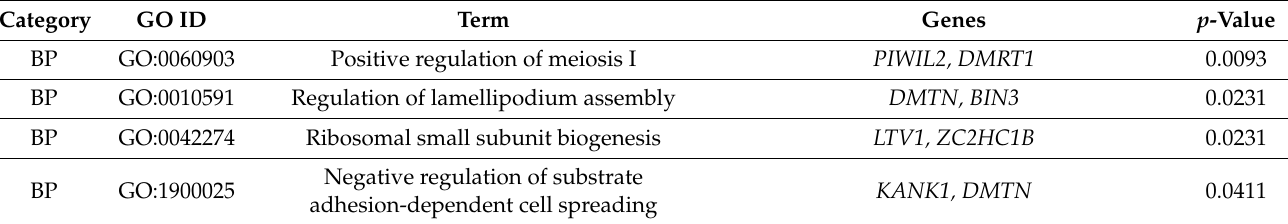
Table 3. The GO and KEGG analyses of Yunling goat vs. Nubian